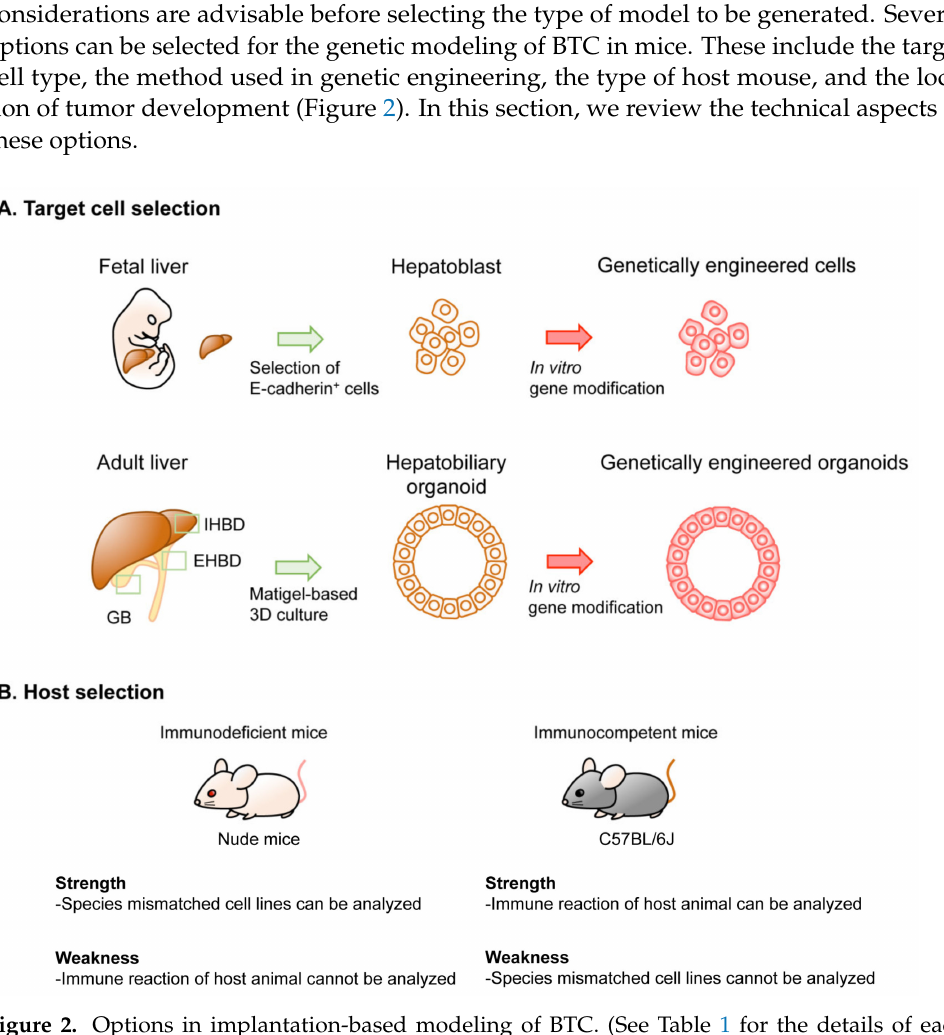
Figure 2. Options in implantation-based modeling of BTC. (See Table 1 for the details of each study.) As examples of options for modeling BTC, target cell selection ( A ) and host selection ( B ) are illustrated. Abbreviations are: IHBD, intrahepatic bile duct and EHBD, extrahepatic bile duct. Nude mice and C57BL/6J strain mice were used as representatives for immunodeficient mice and immunocompetent mice,